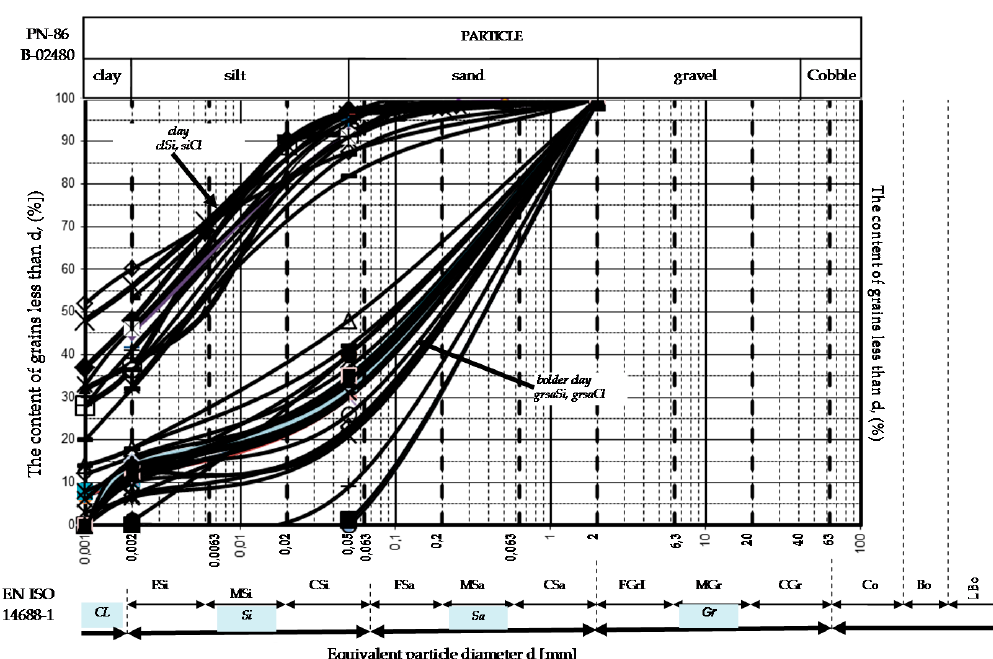
Figure 6. Grain size distribution curve obtained from laboratory tests for the mineral soils from the described sites.